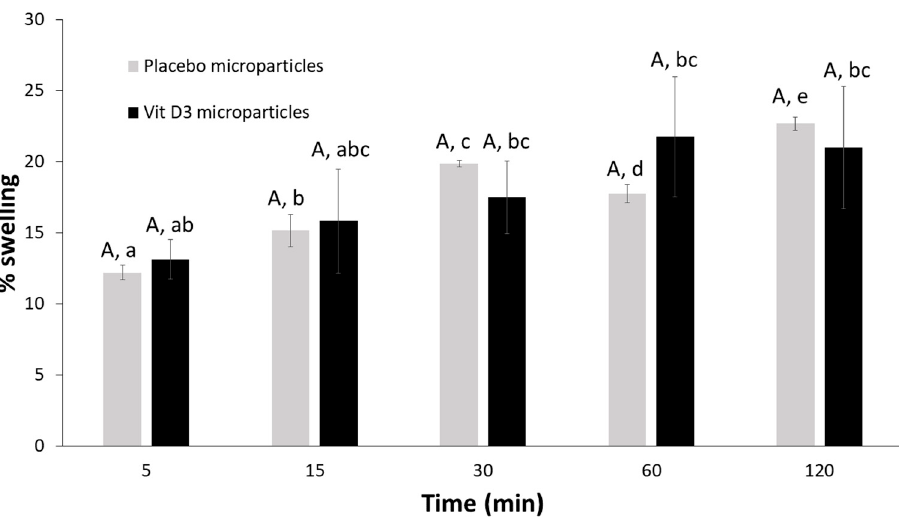
Figure 6. Swelling percentages of dried microparticles in water. Different capital letters over bars show significant differences between samples at the same time intervals ( p < 0.05); while dissimilar lowercase letters indicate significant differences among different time intervals within the same sample ( p < 0.05).